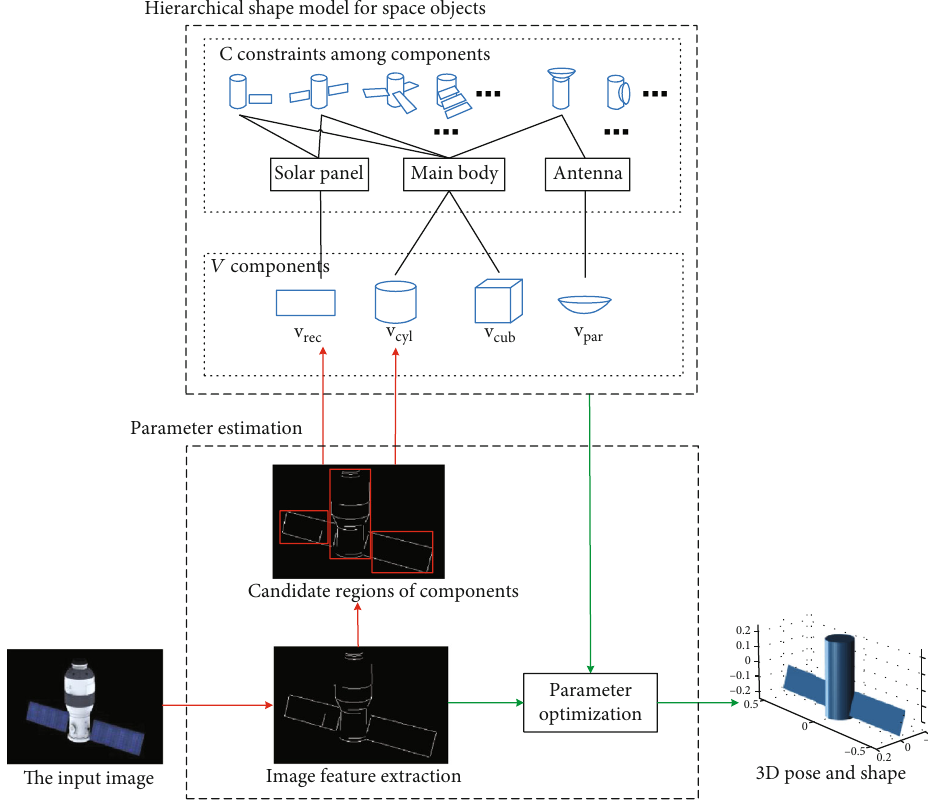
Figure 1: The framework of our method. The upper part is the prebuilt hierarchical shape model. The lower part shows the estimation of the shape and pose from the input image. The red line represents the process of activating the hierarchical shape model, and the green line represents the process of parameter estimation in support of the hierarchical shape model.